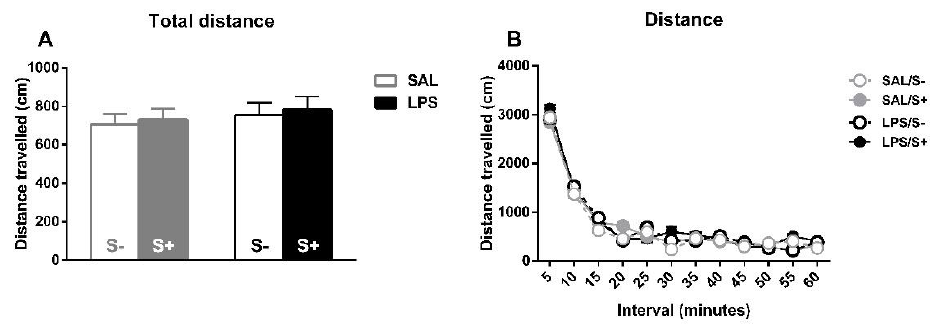
Figure 8. Locomotor activity in saline-control (SAL/S-), LPS-control (LPS/S-), saline-stress (SAL/S+), or LPS-stress (LPS/S+) groups ( n = 12). ( A ) Total distance traveled by the animals on the whole session. ( B ) Reactivity to novel environment (distance traveled on each five-minute interval). No differences were found concerning LPS or stress in any of these measures, although overall habituation to the cage can be observed in terms of a decrease of distance traveled. Data are represented as mean ± SEM.